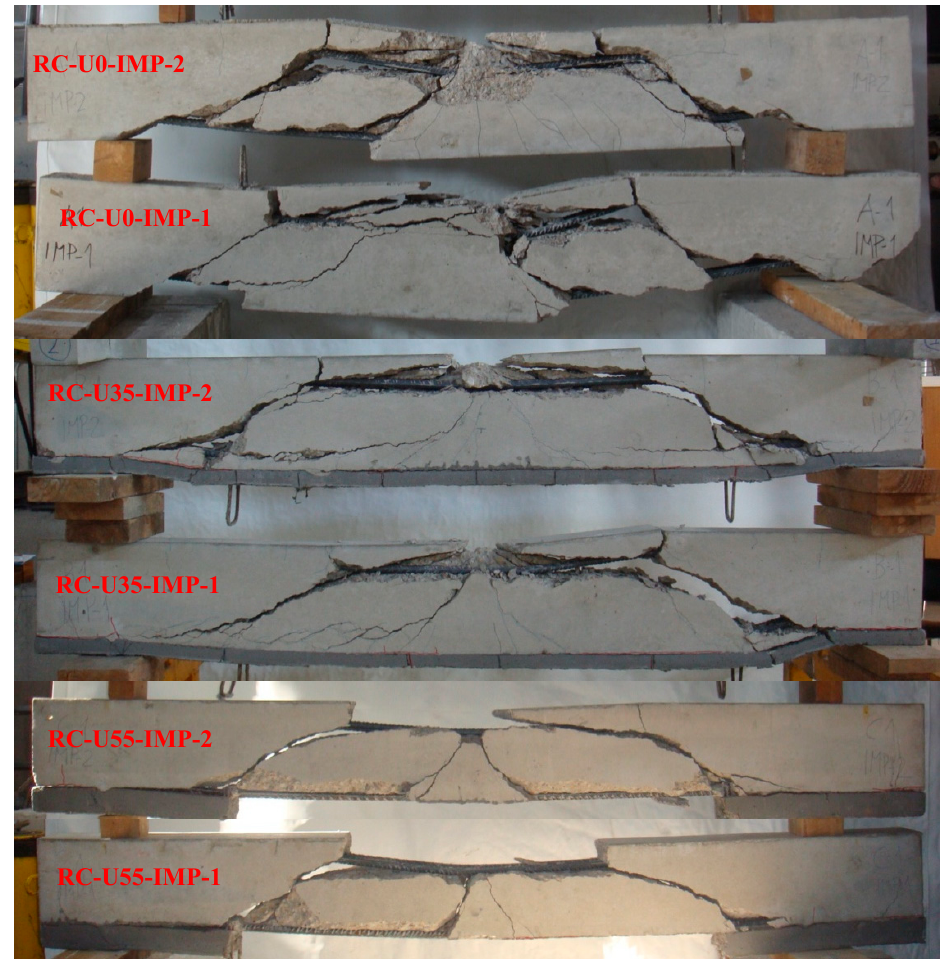
Figure 5. Crack pattern diagrams of tested specimens. Table 2. Summary of test results